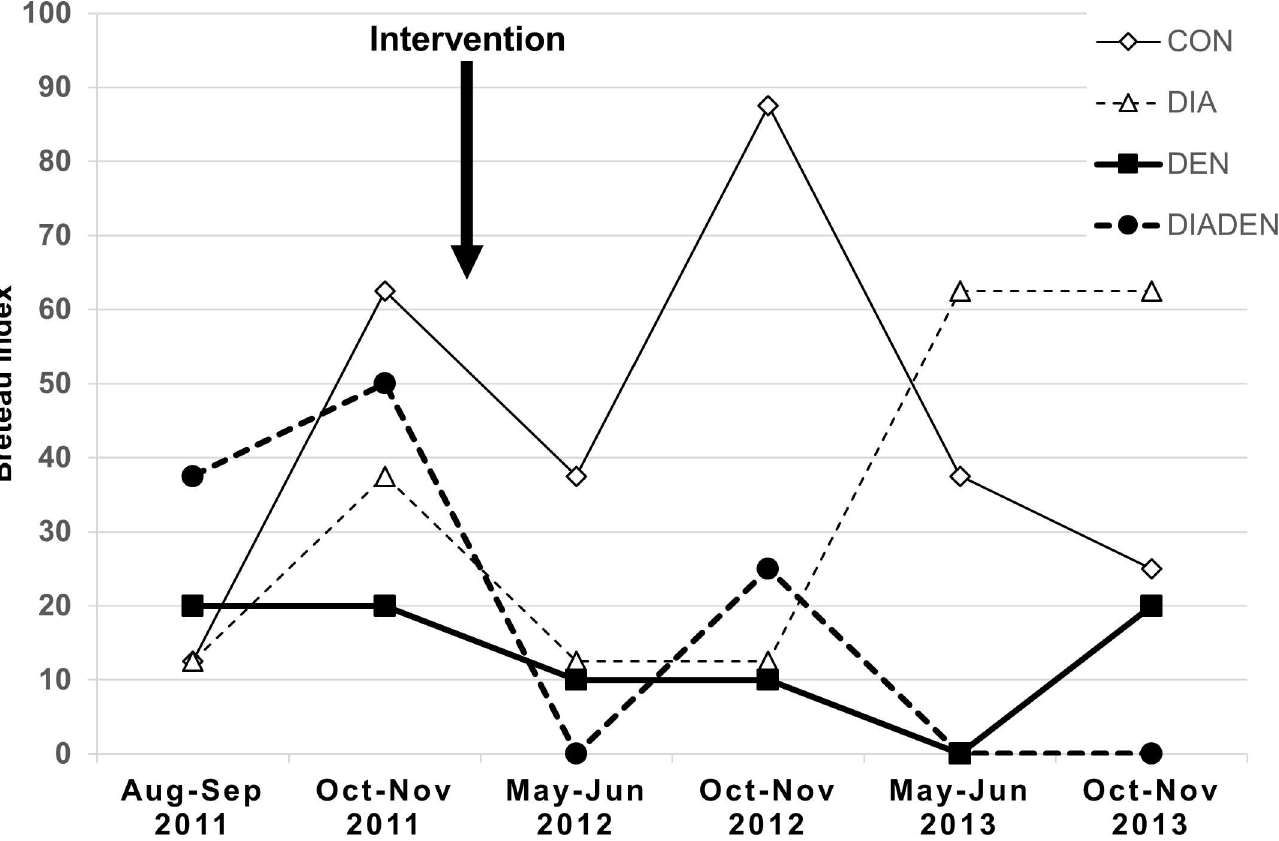
Fig 3. Breteau indices over time. Variation in Breteau index in rural primary schools in four arms receivingeither diarrhea(DIA), dengue(DEN), both (DIADEN), or no intervention(CONTROL) in Anapoima and La Mesa municipalities, Colombia.Rainfall is bimodal with peaks in April-May and